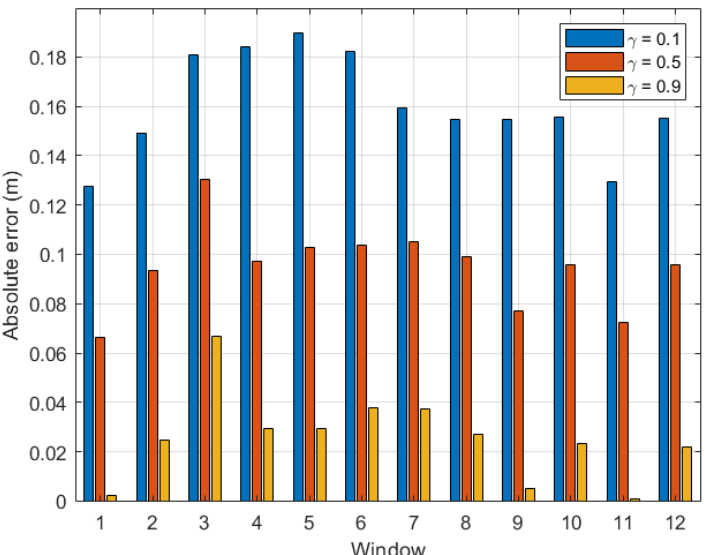
Figure 6. Indoor walking (dataset 1): absolute error with respect to time windows tw i , i ∈ [ 1,12 ]